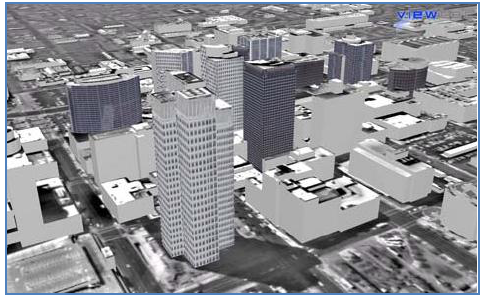
Fig. 1 3D city model from QuickBird images reconstructed by the CC-Modeler (Kocaman and others,